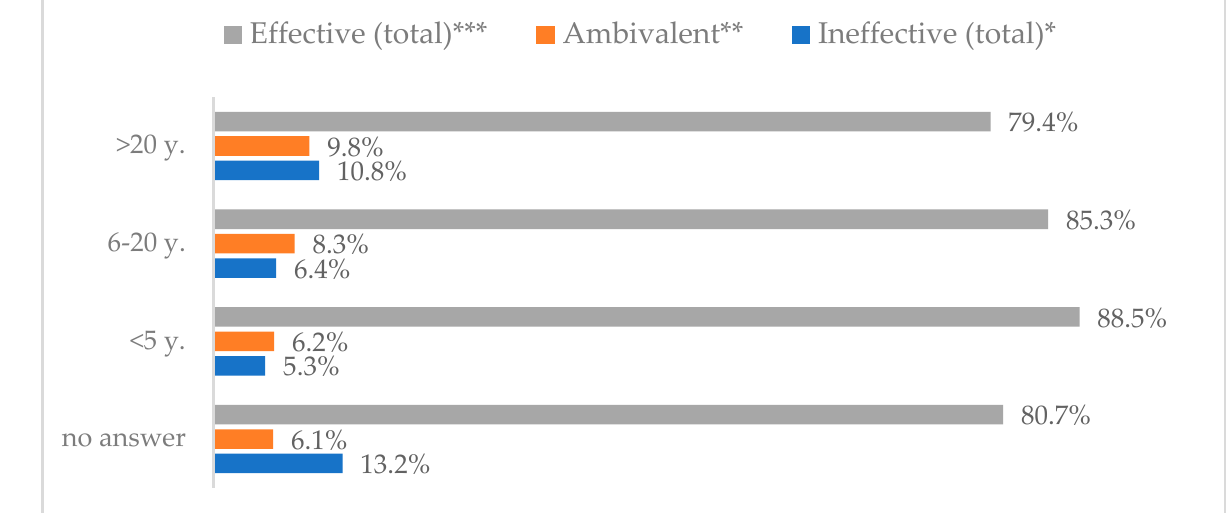
Table 5. Evaluation of influenza vaccination as a means of preventing influenza virus infection by sociodemographic category ( N = 950).